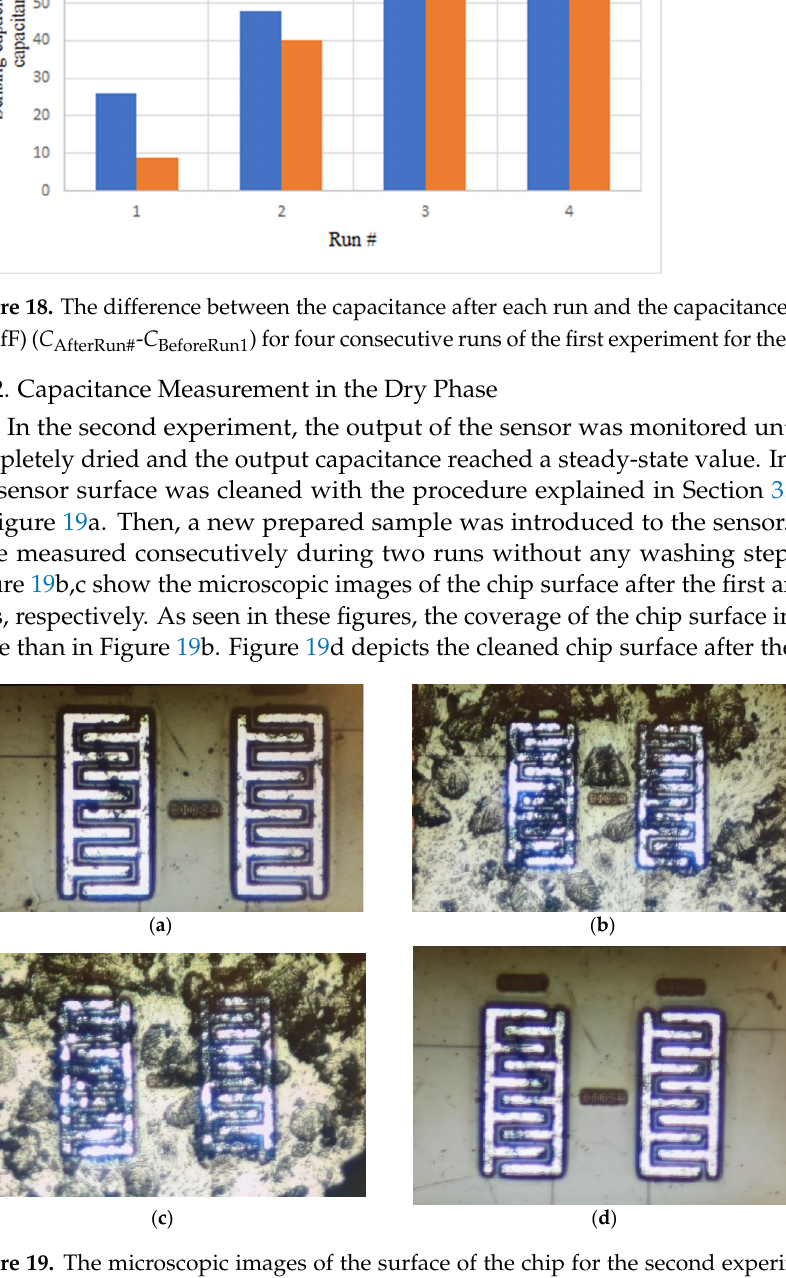
Figure 18. The difference between the capacitance after each run and the capacitance before the first run (fF) ( C AfterRun# - C BeforeRun1 ) for four consecutive runs of the first experiment for the two electrodes.